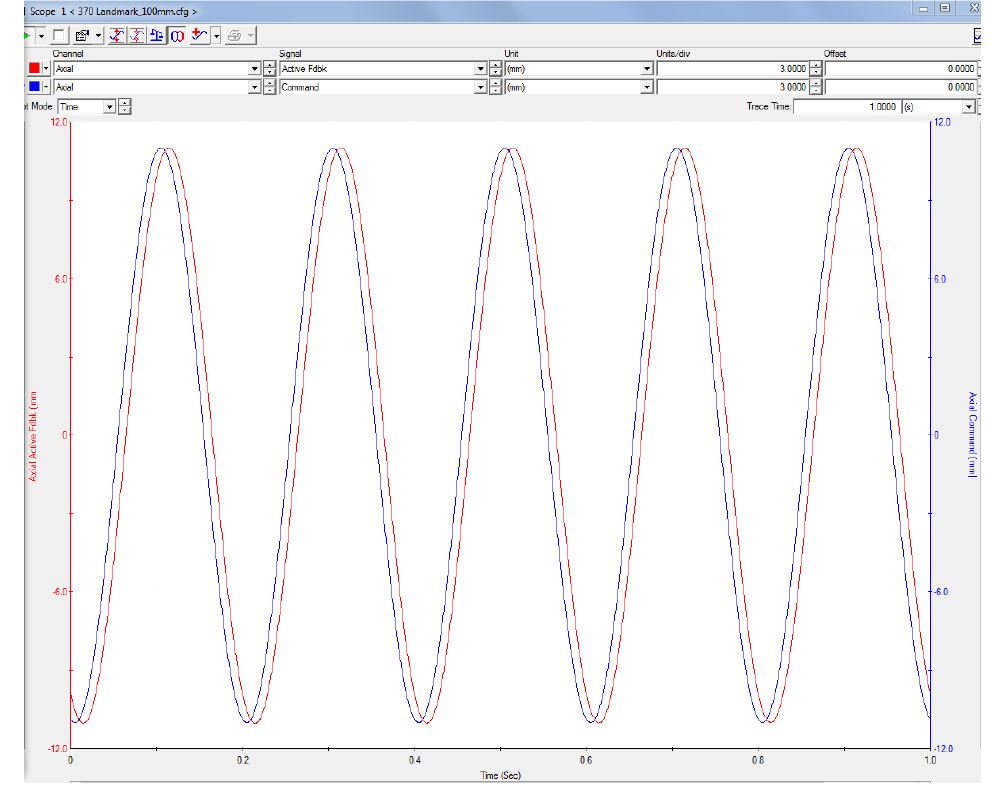
Figure 4. Screenshot of command and feedback signals for the MTS hydraulic machine .